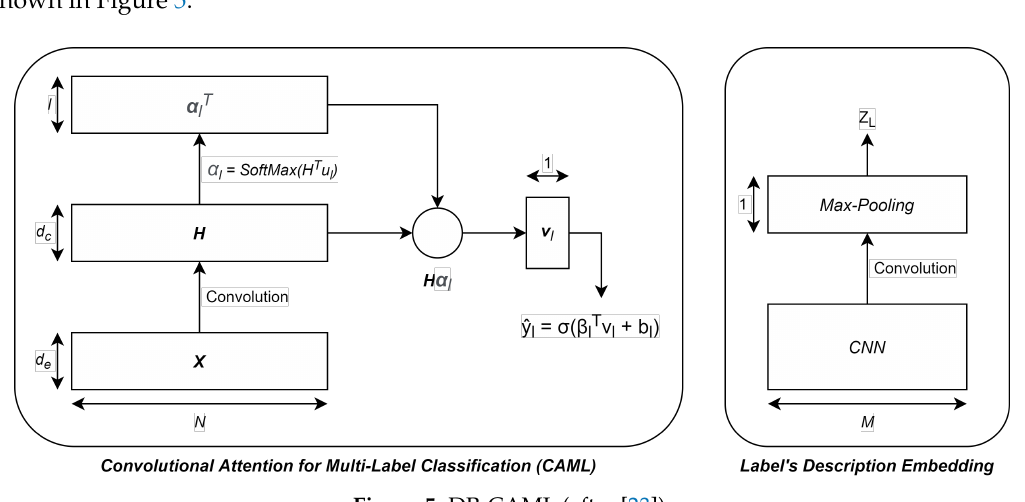
Figure 5. DR-CAML (after